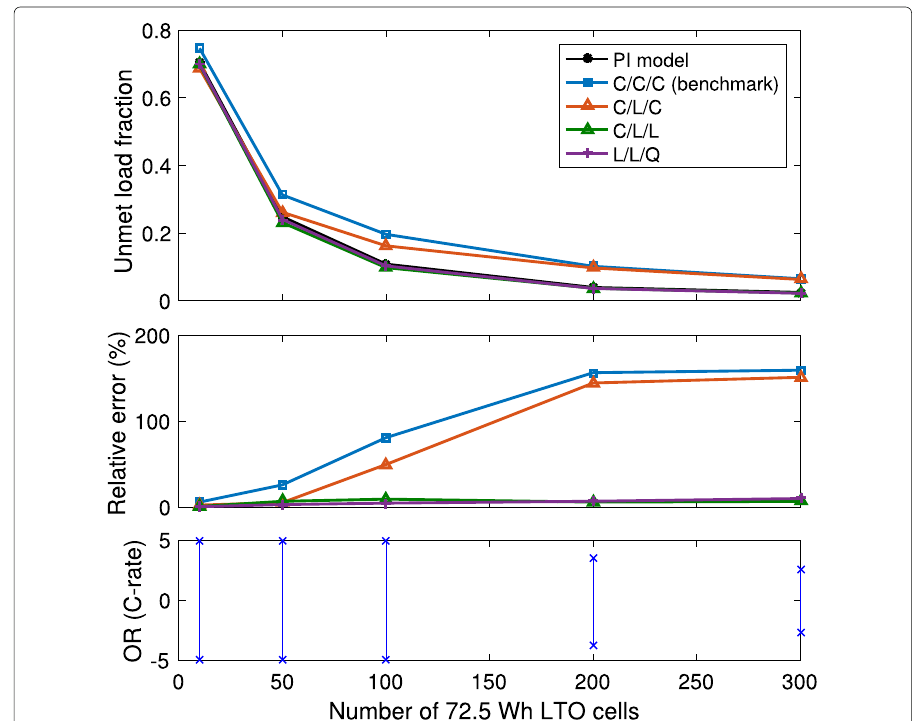
Fig. 8 Unmet load for different battery sizes, computed using five different models. Relative error is with respect to the PI Model, and the effective OR calculated by the PI model is shown in the bottom-most